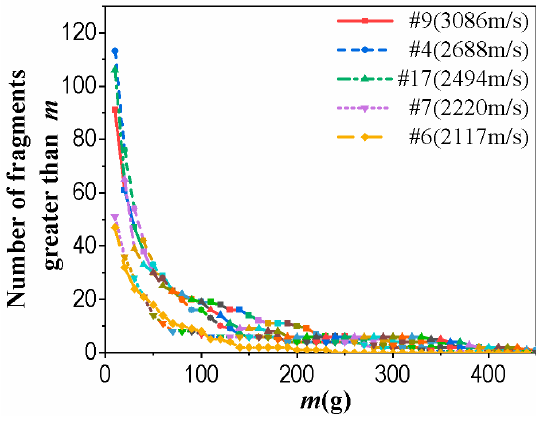
Figure 12. Concrete fragment mass distribution.